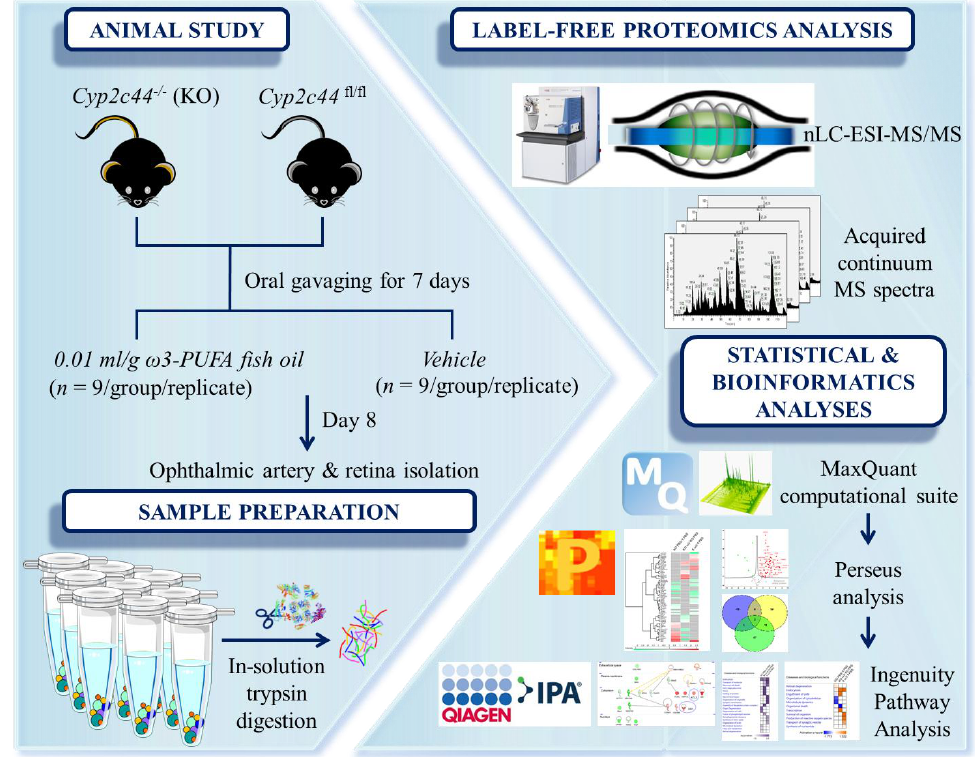
Figure 1. Workflow overview. The schematic overview of the experimental design of this study. Ophthalmic artery and retina were harvested from Cyp2c44 − / − (KO) and Cyp2c44 fl/f (floxed littermate control) mice following oral gavaging with either ω -3 PUFA-enriched fish oil or vehicle control for 7 days. Samples were subjected to in-solution trypsin digestion prior to subjecting to bottom-up